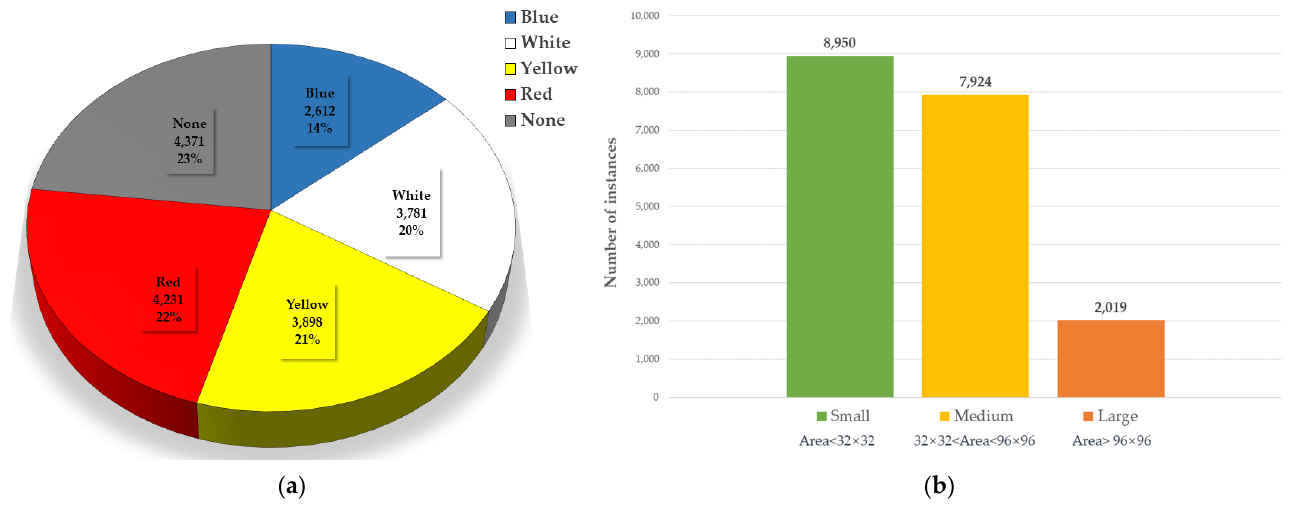
Figure 12. Details of the GDUT-HWD dataset, where ( a ) is the number of each category as a percentage of ground truth, and ( b ) is the number of instances of large, medium, and small sizes.